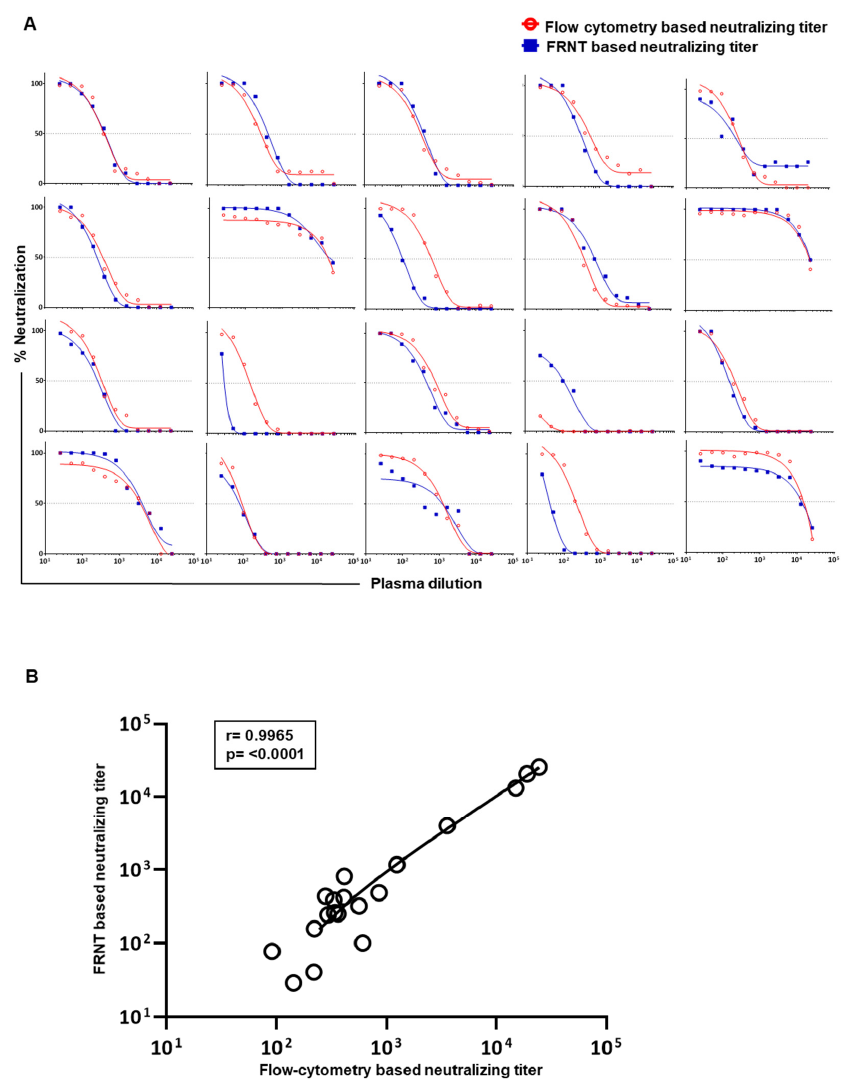
Figure 3. Optimization of the flow cytometry based neutralizing assay such that the neutralization titers obtained by this assay are in concordance with the traditional foci-based neutralizing assay. ( A ) Raw data shown are for flow cytometry staining plots for Vero cells that were seeded at the indicated numbers per well and then infected with the indicated PFU of DENV2 that was preincubated with titrating concentrations of 4G2 monoclonal antibody. Cells were stained 24 h post- infection using anti-dengue 2H2 monoclonal antibody. Red box and red shadow on a flow cytometry plot indicate the approximate position where 50% neutralization of virus was achieved. ( B ) Concentration of 4G2 monoclonal antibody needed to cause 50% neutralization in the flow cytometry based assay using graded number of Vero cells at an MOI of 1. ( C ) Dilution of plasma needed to cause 50% neutralization in the flow cytometry based assay using graded number of Vero cells at an MOI of 1. Two individual plasma samples are shown.